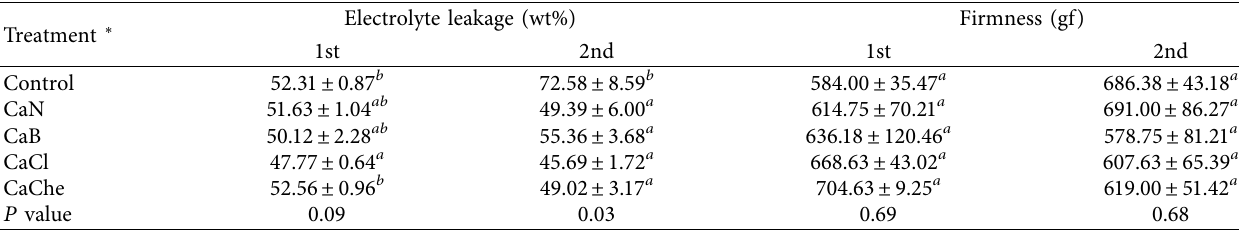
Table 8: Effect of calcium on electrolyte leakage and firmness of pineapple